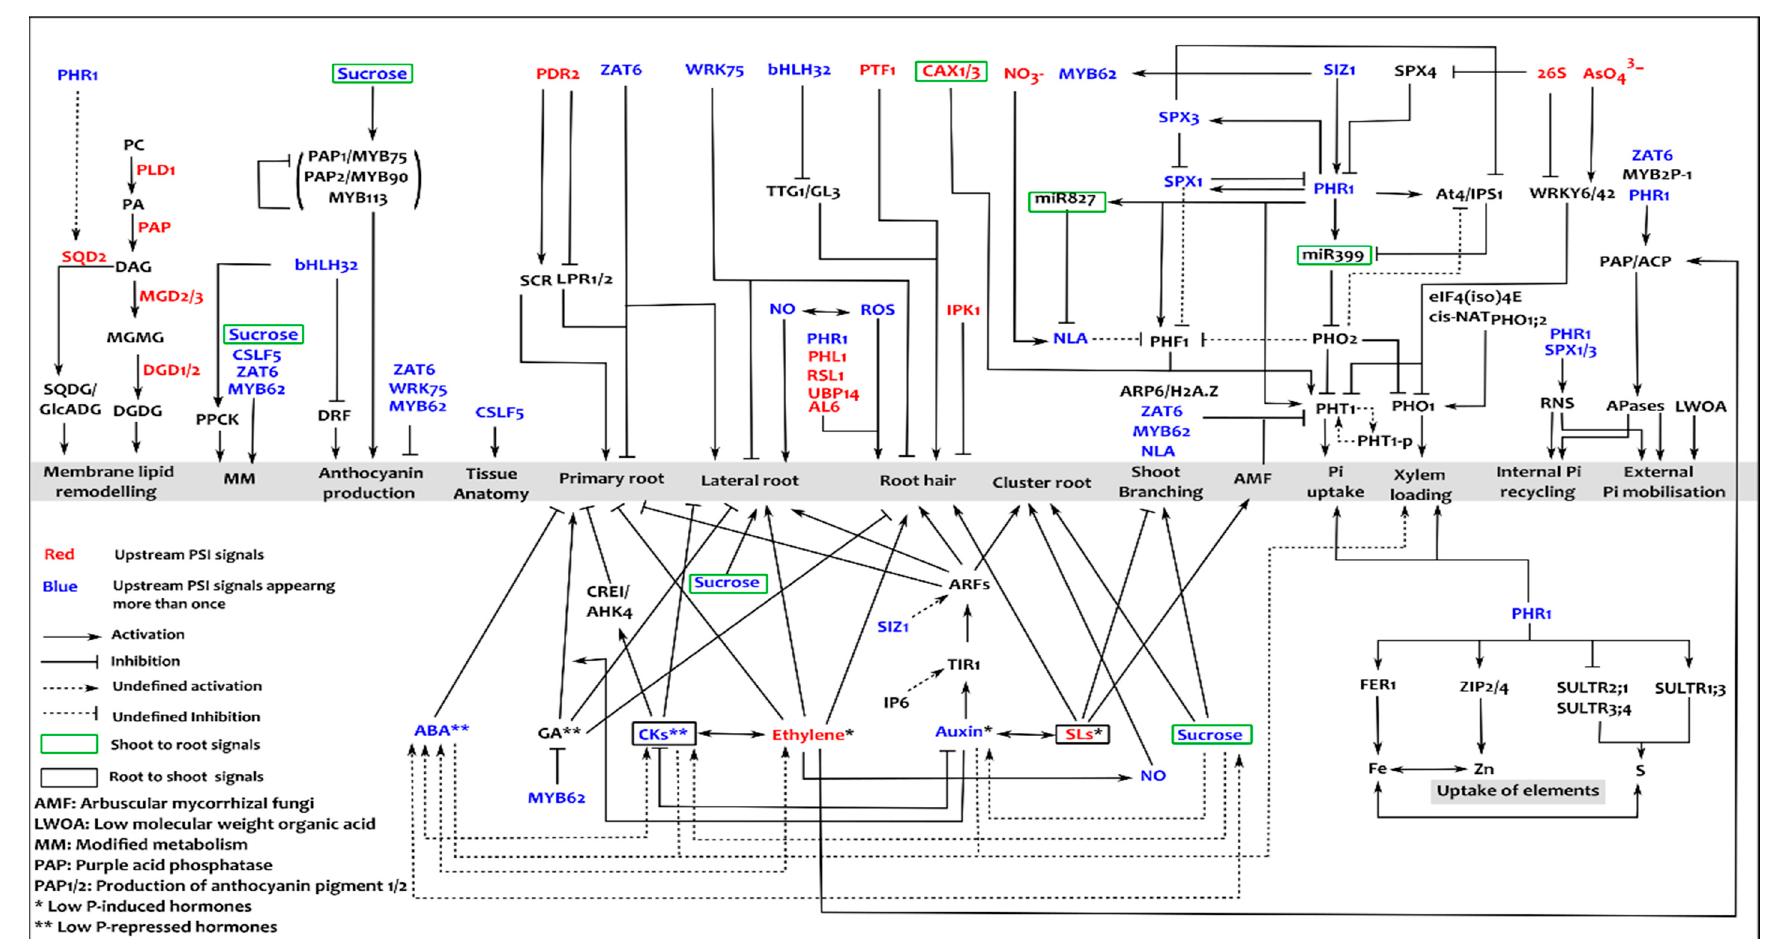
Figure 2. Molecular signalling in phosphate starvation responses. The different responses are specified in the grey bands, with hormonal regulation and transcription factor/signal/enzyme regulation delineated respectively below and above; the upstream signal and regulators are denoted in red and blue depending on whether or not they feature one or more times in the network, with some in green and purple boxes respectively to denote shoot-to-root and root-to-shoot systemic signals; the types of edges (interactions) and meaning of the acronyms are shown in the key on the lower left.